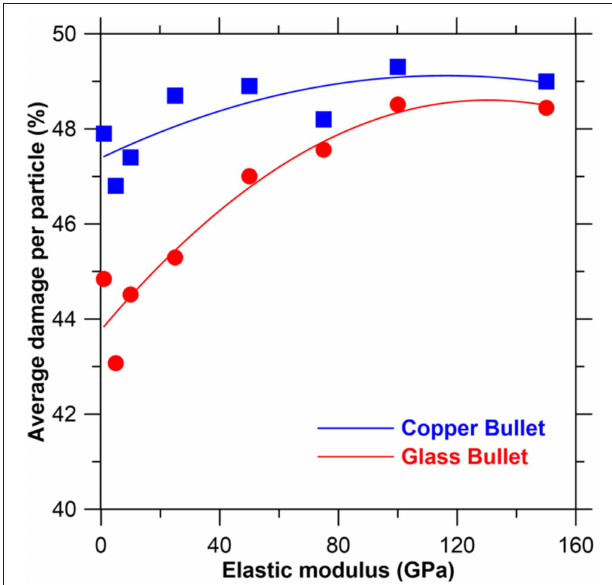
FIGURE 6 | Average damage per particle of the glass plate with respect to the elastic modulus of the plate.